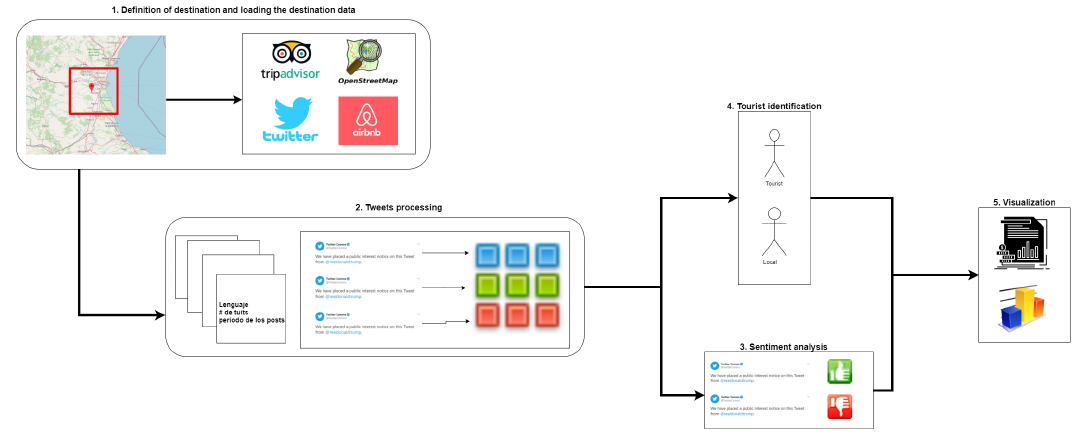
Figure 2. Process overview supported by BITOUR